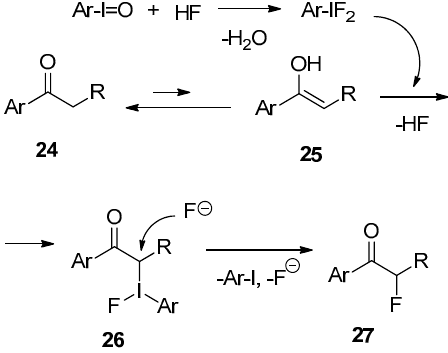
Scheme 9. Proposed mechanism for electrophilic fluorination.